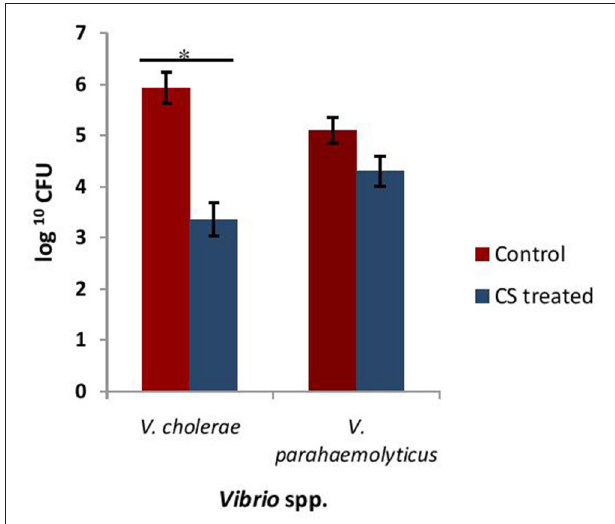
FIGURE 6 | The numbers of CFU of Vibrio spp. that adhered to HCT-15 cell line in the absence and presence of CS of L18. Bars are representative of the mean, whereas, error bars are representative of standard deviation of three independent experiments. *Significance ( p < 0.001) was measured by using unpaired Student’s t -test.